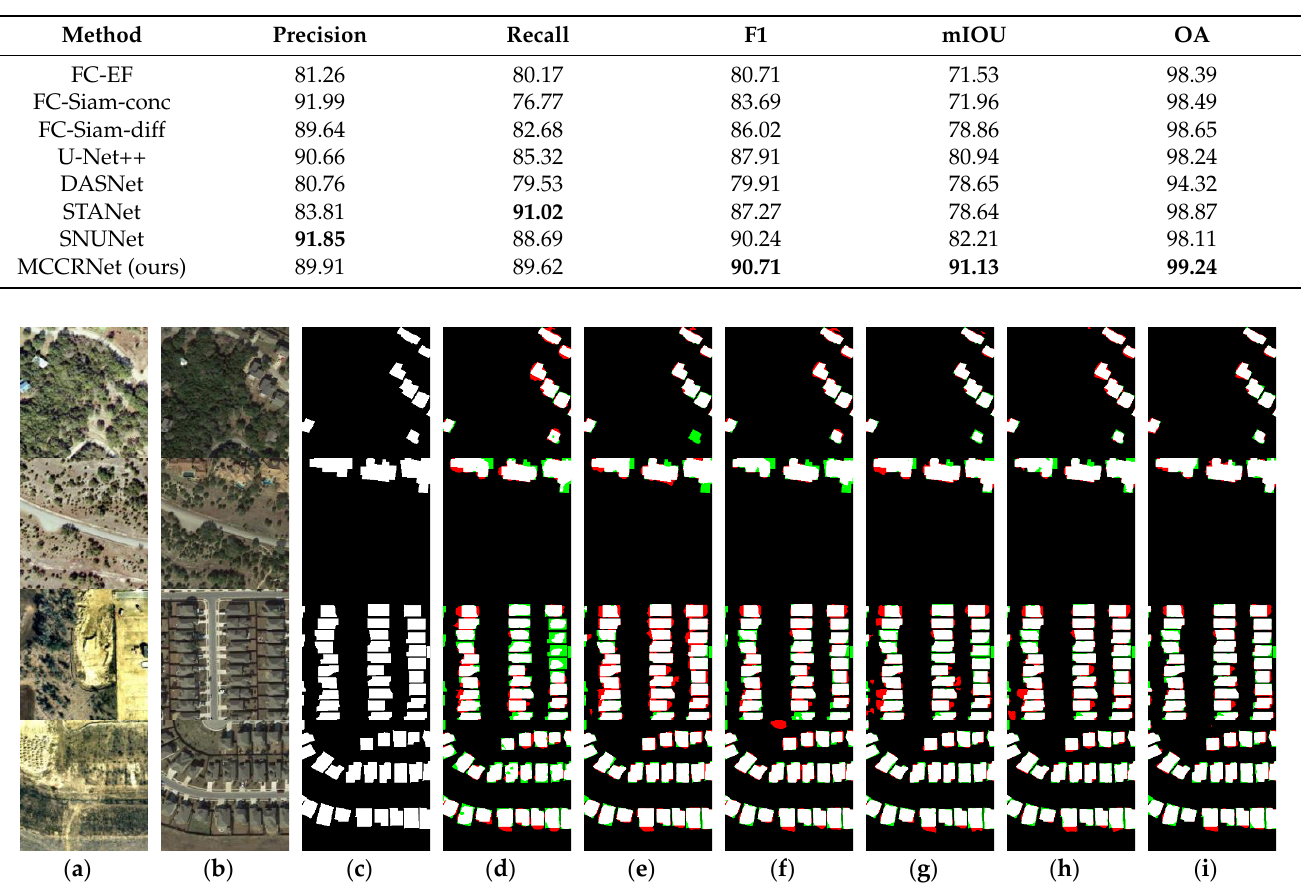
Table 6. Comparison of results on the LEVIR-CD dataset. The bold numbers indicate the best results.